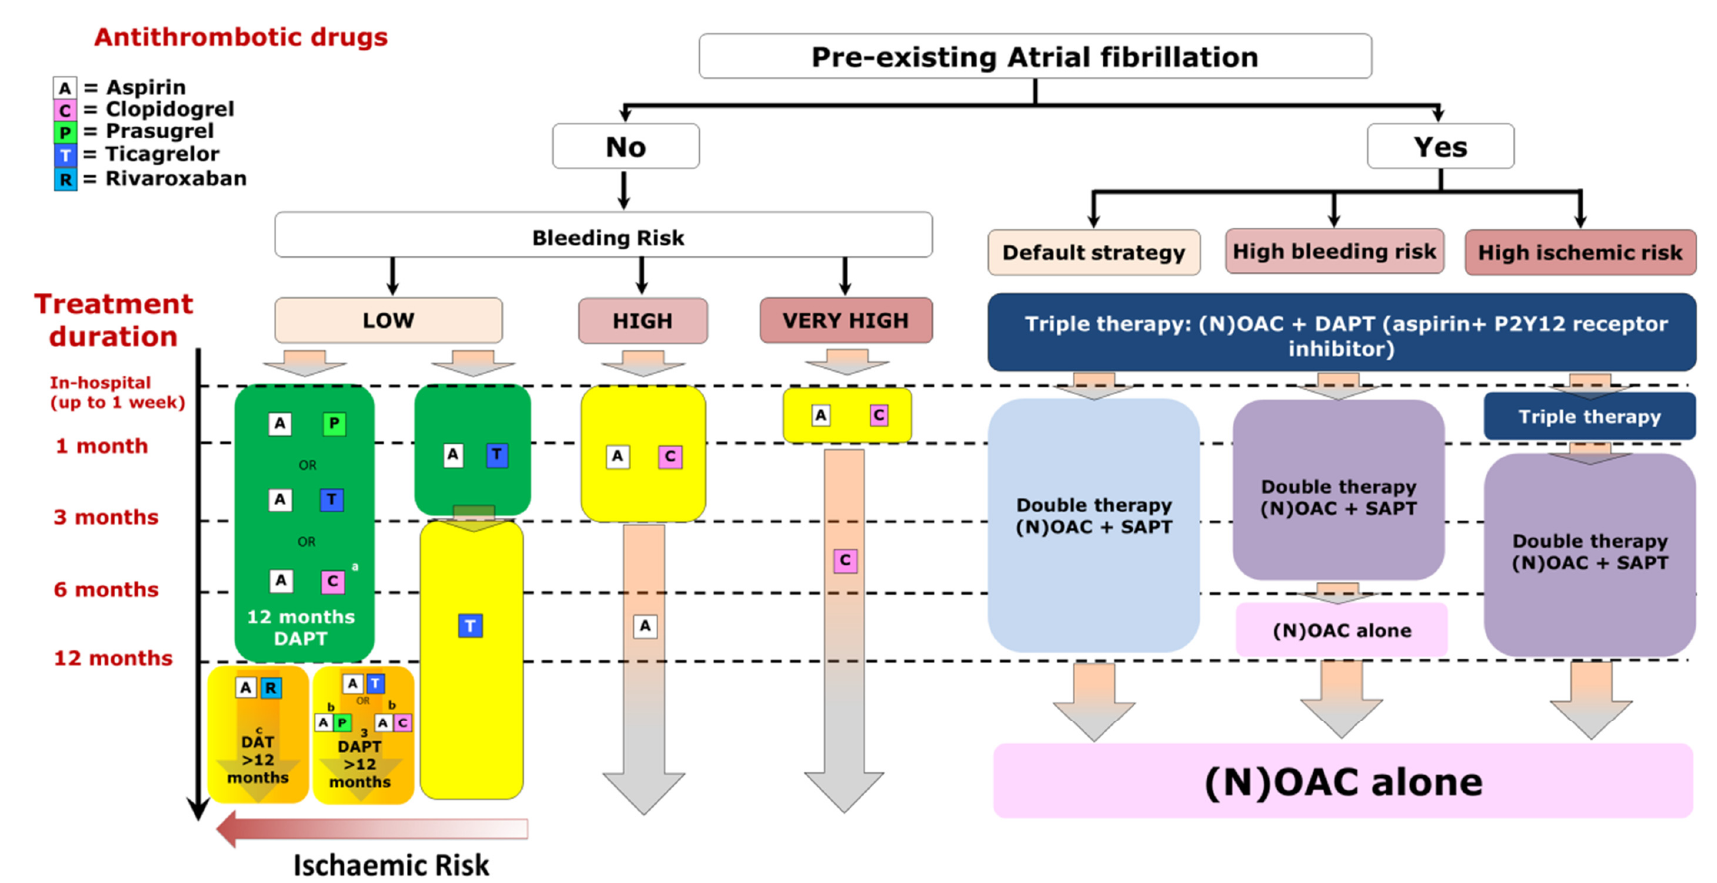
Figure 3. Antithrombotic regimen following PCI for NSTE-ACS according to the 2020 ESC NSTEMI guidelines. NSTE-ACS: non-ST-segment-elevation acute coronary syndrome; ESC: European society of Cardiology; (N)OAC: (non-vitamin K antagonist) oral anticoagulant; DAPT: dual antiplatelet therapy.